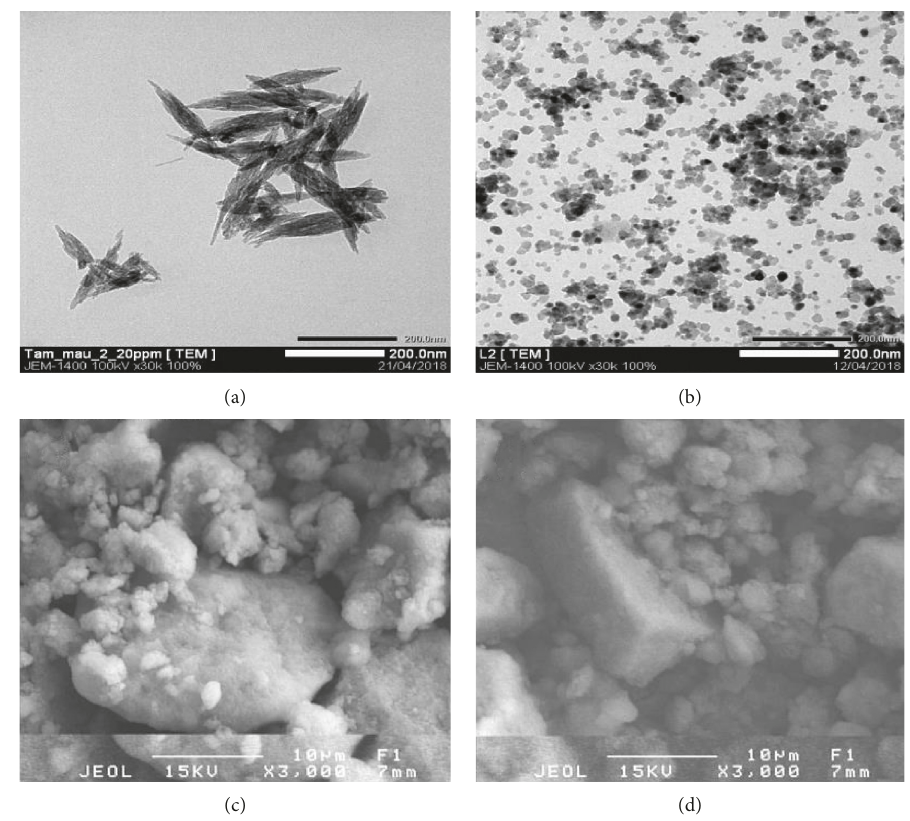
Figure 2: TEM and SEM images for HA (a, c) and Zn-HA (b,